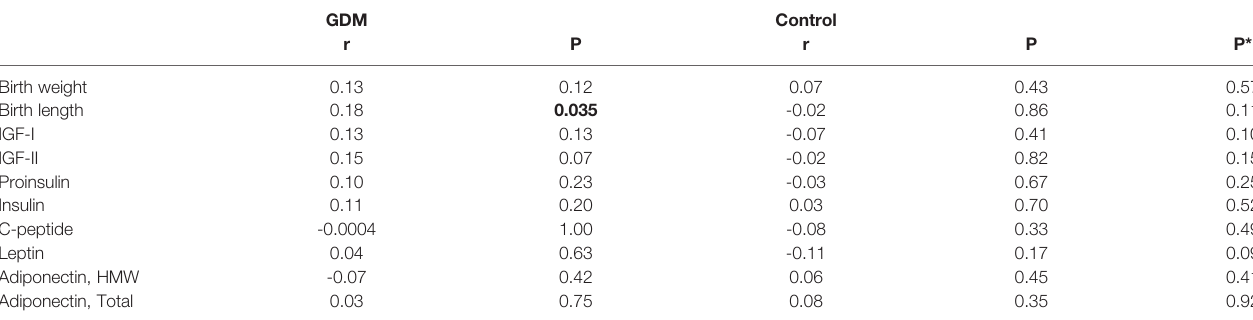
TABLE 3 | Cord blood FGF19 in correlations with birth weight, birth length and fetal growth factors, leptin and adiponectin in the newborns of GDM and euglycemic (control) mothers. GDM Control r P P P* Birth weight